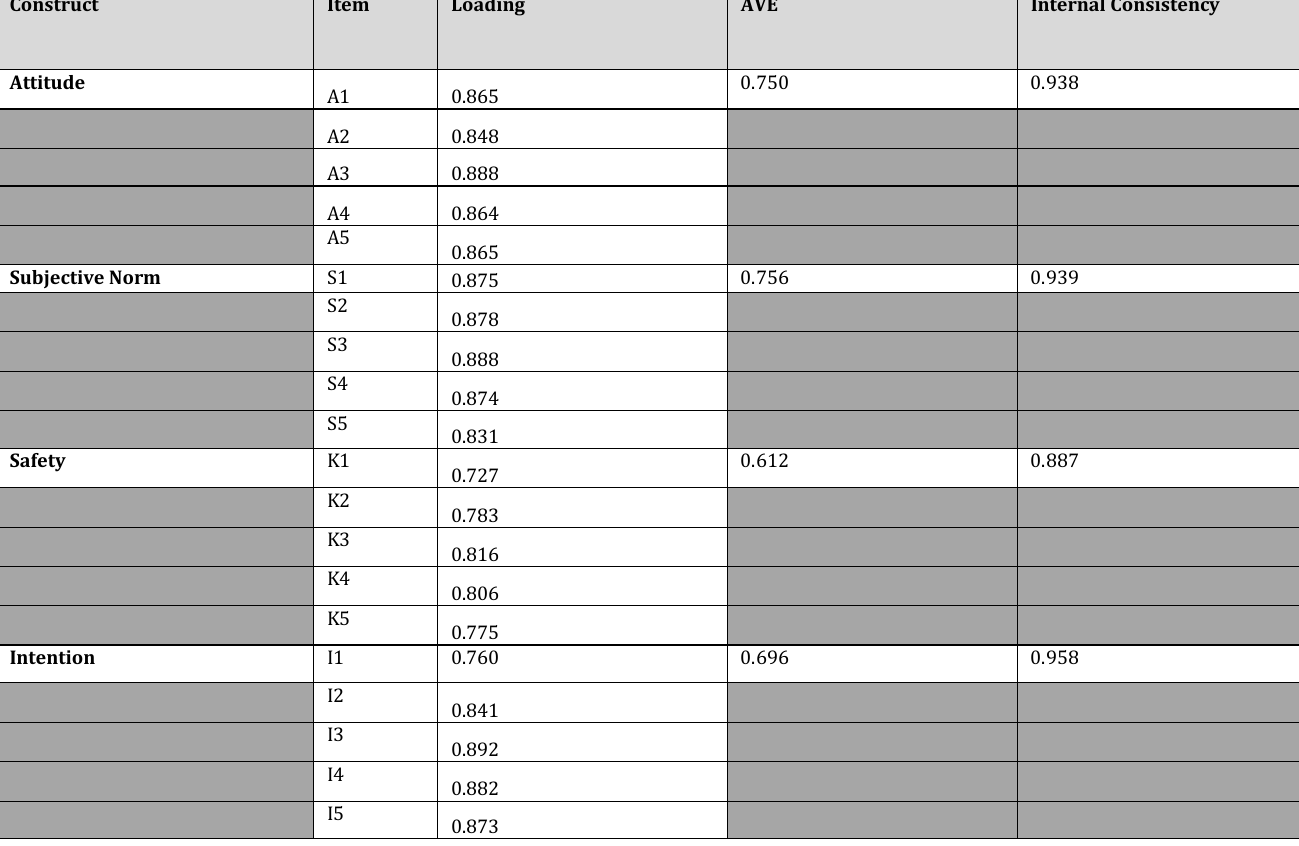
Table 1: Measurement Model